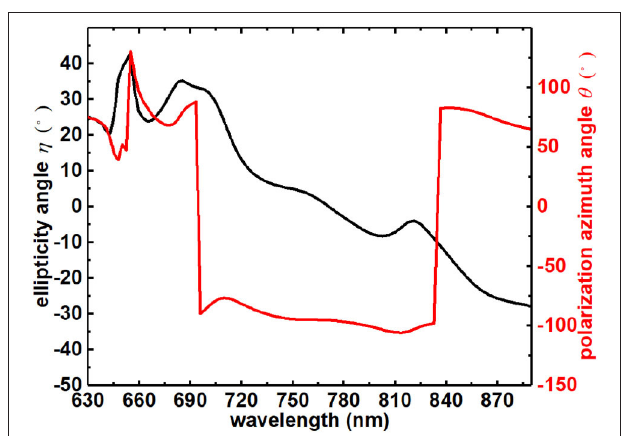
FIGURE 7 | The polarization azimuth angle θ (black line) and ellipticity angle η (red line) of x -polarized incident